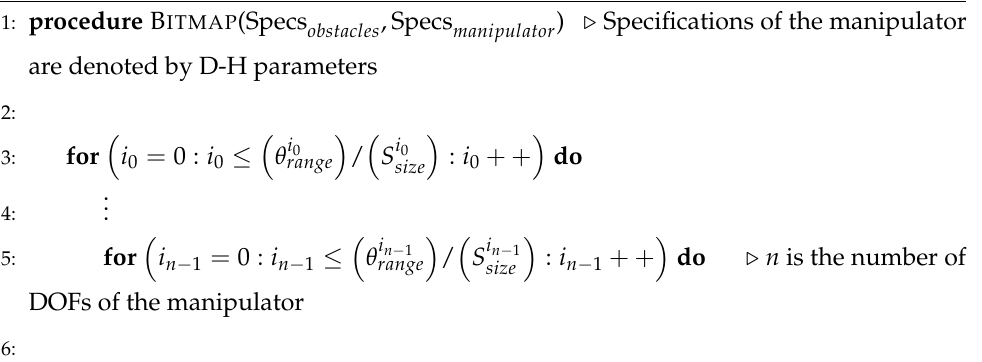
Algorithm 1 Bitmap creation of the configuration